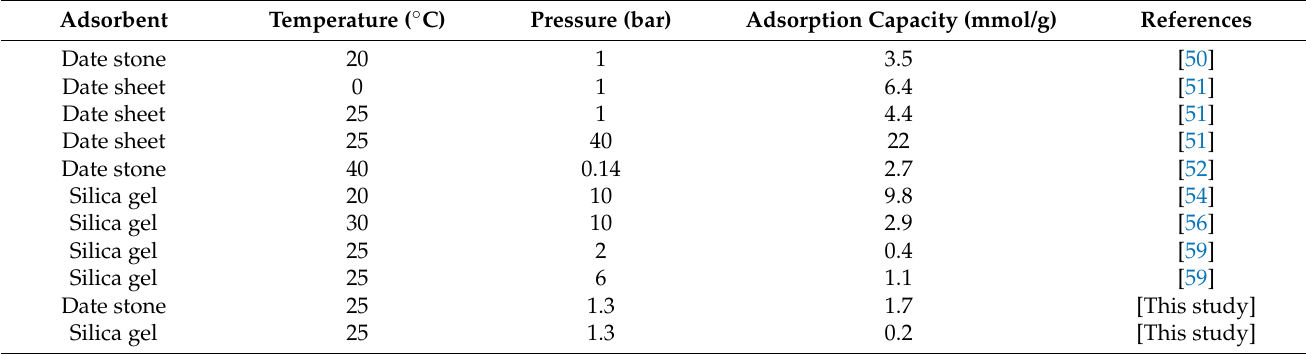
Figure 13. The dependence of the initial CO 2 level for SG and AC at C o = 5%, F = 4 lpm on ( a ) CO 2 uptake and ( b ) efficiency. Table 3. Summary of reported CO 2 uptakes of various adsorbents.